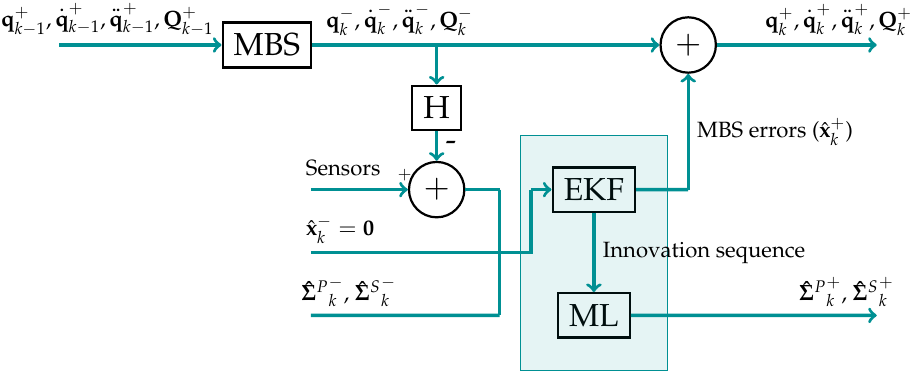
Figure 2. Simplified flow diagram of a time step of the adaptive errorEKF with force estimation. MBS refers to the multibody system, whose output is the predicted position, velocities and accelerations of the system. H is the observation matrix, employed to obtain the virtual measurements, which are compared with the measurements from the sensors. ˆ Σ P and ˆ Σ S are the PNCM and MNCM, respectively, where the superscripts − and + refer to the a priori and a posteriori estimations. EKF represents the application of the extended Kalman filter equations, whose outputs are the estimated errors in the predicted state vector (MBS errors). ML refers to maximum likelihood and is where the noise covariance matrices are